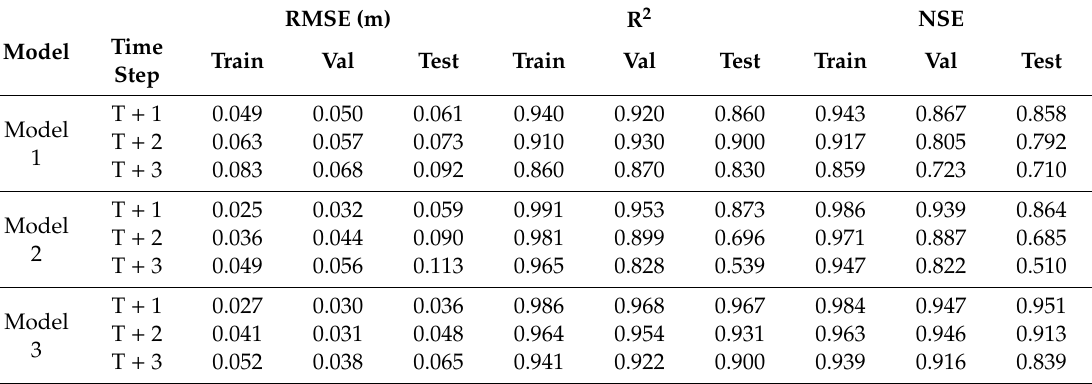
Table 3. Performance of one- to three-hour-ahead forecasts of the Model 1, Model 2, and Model 3.